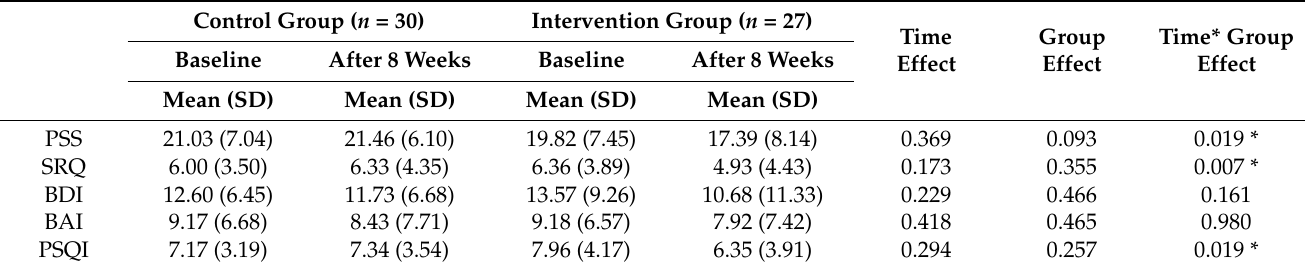
Table 4. Experiment 2: Comparison between the control and the intervention groups at baseline and after 8 weeks (covariate by